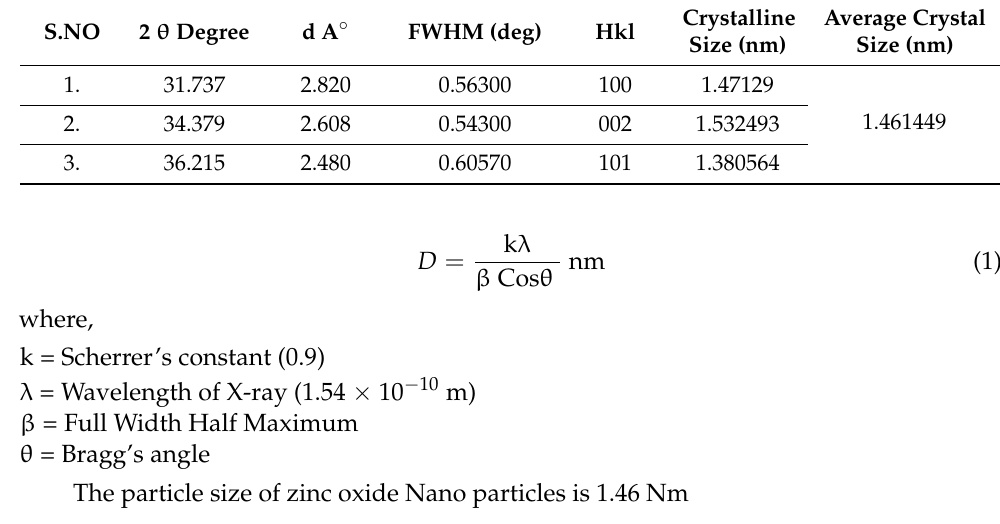
Figure 3. FTIR analyses of zinc oxide nanoparticles (ZNP). The FTIR spectrum is shown in Figure 3, the peaks observed at distances of 1650 and 3353 cm − 1 contribute to bending and stretching the moisture vibrations present in the which is seen in spectral peak in the form of absorbance assigned to leaf extract, and was observed in the region of 3196, 1650, 1102 and 871 cm − 1 . The exhibited absorption bands, especially in the corresponding rang 3353, 3196 cm − 1 (phenol O-H), 1626 cm − 1 of (C=C), 1650 cm − 1 for (C=N), 1102 cm − 1 for (C-O) and 871 (C=C bending), proves the existence of synthetic and atmospheric solution residue Table 2.